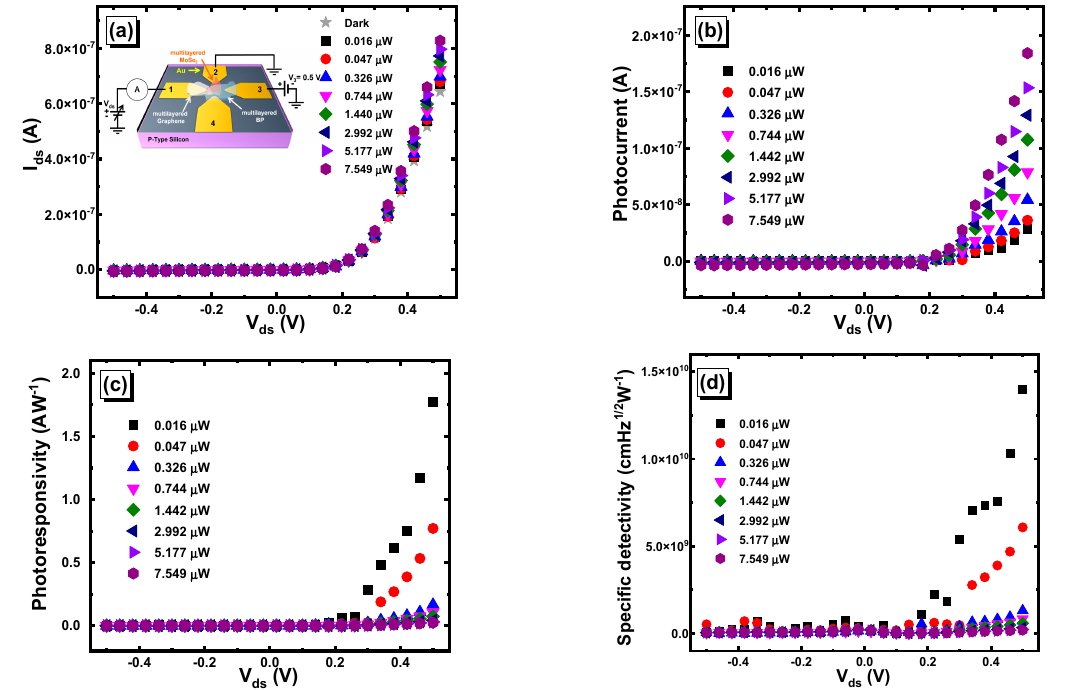
Figure 6. Polarization voltage and laser power dependence in Gr/n-MoSe 2 heterojunction: ( a ) Output characteristics (I ds –V ds or I 12 –V 12 ), ( b ) photocurrent, ( c ) photoresponsivity, and ( d ) specific detectivity at gate voltage (V G or V 3 ) of 0.5 V.